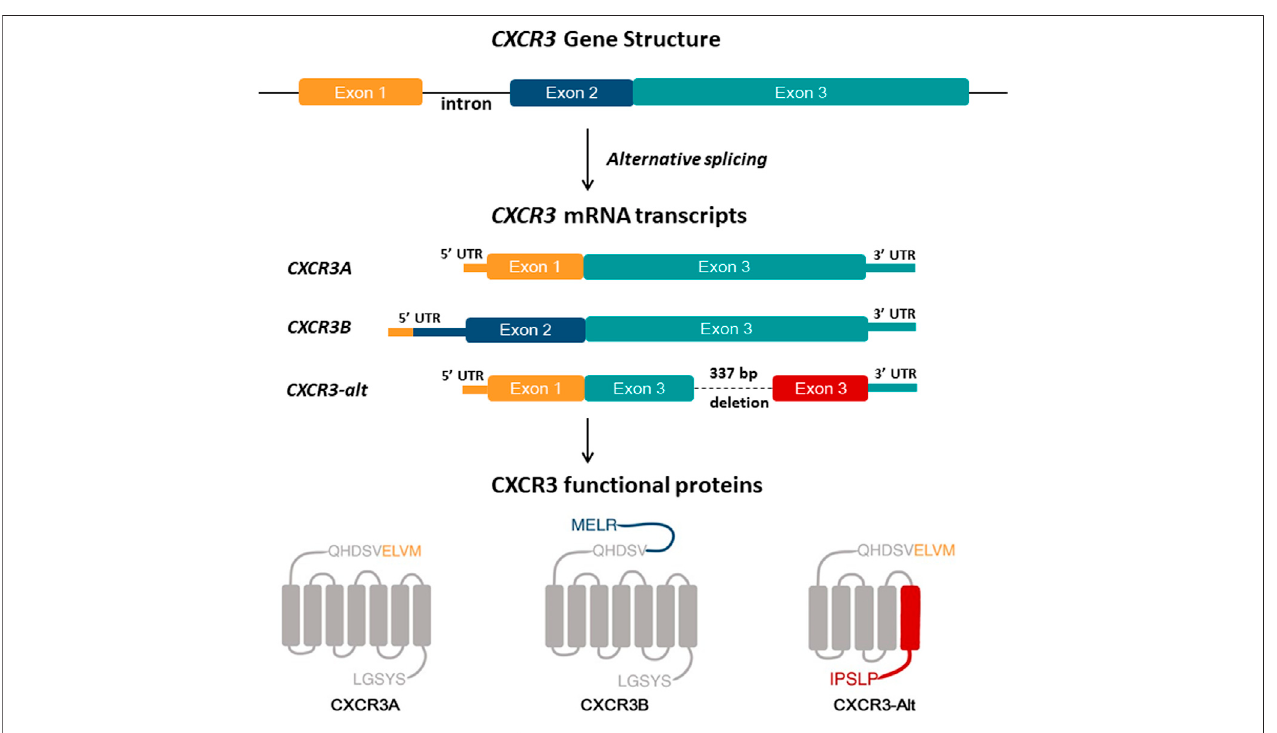
FIGURE1| OverviewofthehumanCXCR3geneandCXCR3isoformsstructure.HumanCXCR3hasthreesplicevariants; CXCR3Aisasplicedproductofexon-1 and exon-3 of the CXCR3 gene. Alternative splicing of exon-2 and exon-3 results in CXCR3B, with a longer N terminal than CXCR3A by 52 extra amino acid residues. CXCR3-Altisformedbydeletionof337 bpinexon3,resultinginaproteinhavinganNterminalandfourtransmembranedomainsidenticaltoCXCR3Aandadifferent fi fth transmembrane domain and C terminal than CXCR3A and CXCR3B.